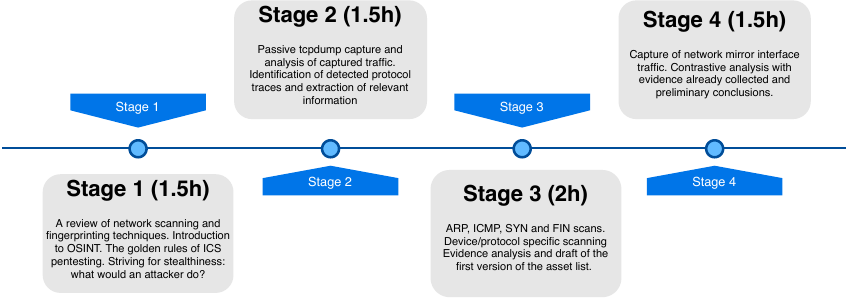
Figure 13. Organization of the second training module (6.5